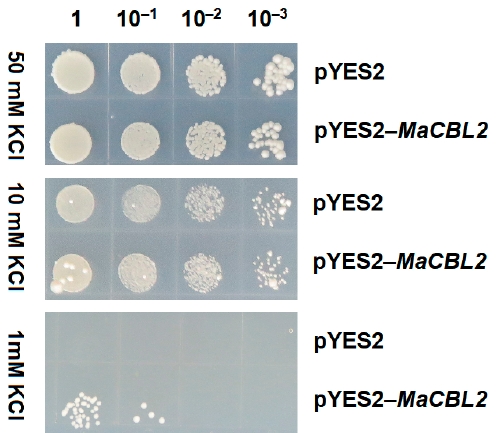
Figure 7. Growth status of the K + -uptake-defective yeast mutant R5421 expressing pYES2– MaCBL2 and pYES2 (control).